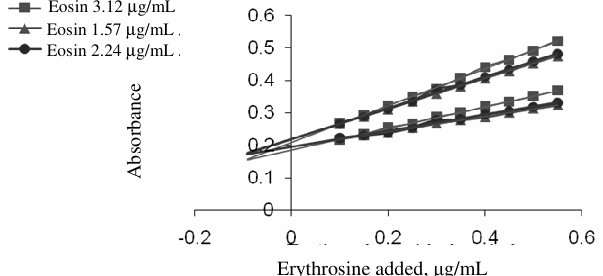
Figure 6. Plot of H -point standard addition method for simultaneous determination of fixed amounts of erythrosine concentration (2.93 µ g/mL) and different amounts of eosin, when different standard eosin solutions are added